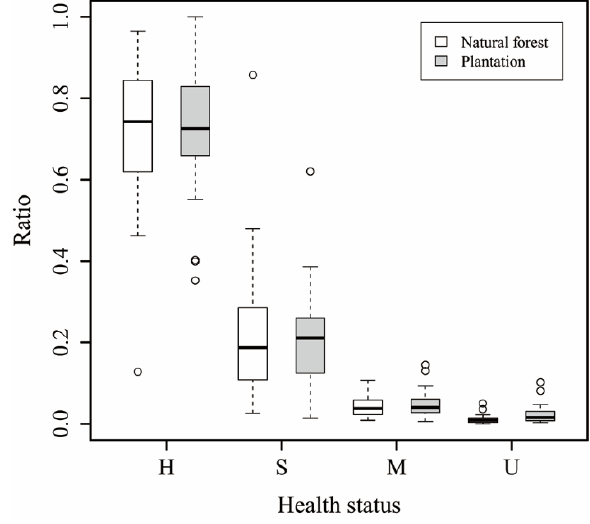
Figure 2. Health status of natural forests and plantations in China. “H” represents healthy; “S” represents sub-healthy; “M” represents moderately healthy; “U” represents